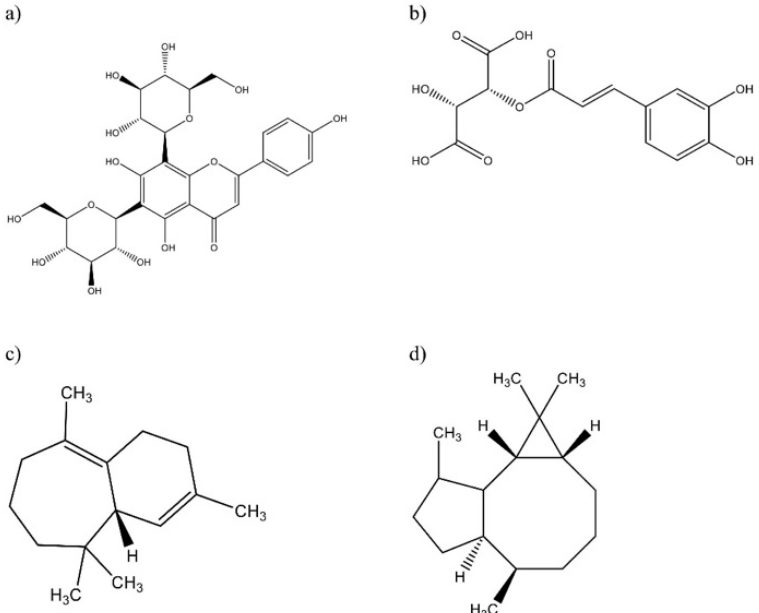
Figure 4. ( a ) Vicenin-2 and ( b ) caftaric acid, identified from polyphenolic compounds (PC) by UPLC/QToF-M 2 ; ( c ) α -himachalene and ( d ) α -gurjunene identified from essential oil (EO) by GC/MS.